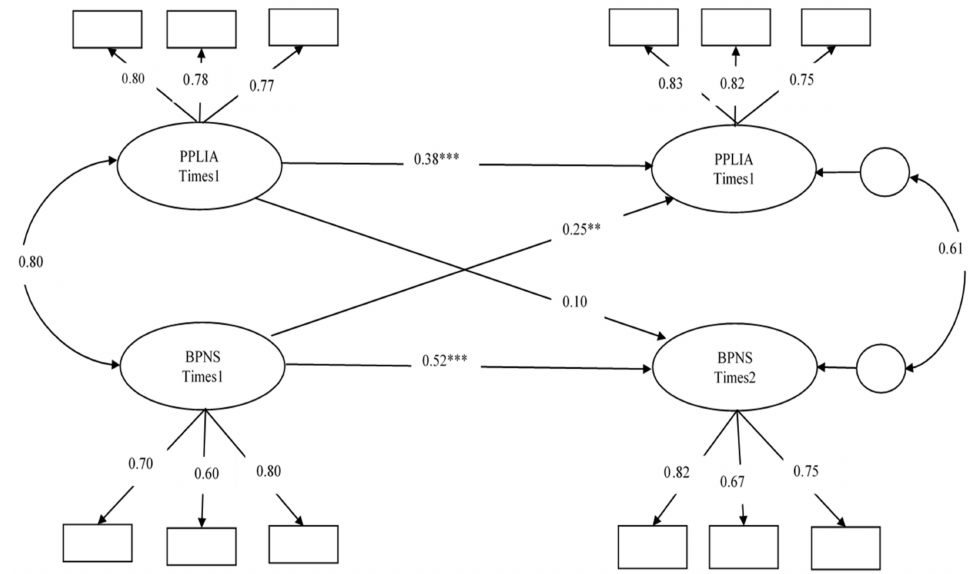
Figure 2. The full cross-lagged conceptual models. This figure only presents paths significant at p < 0.05; it omits inter correlations between error variances for